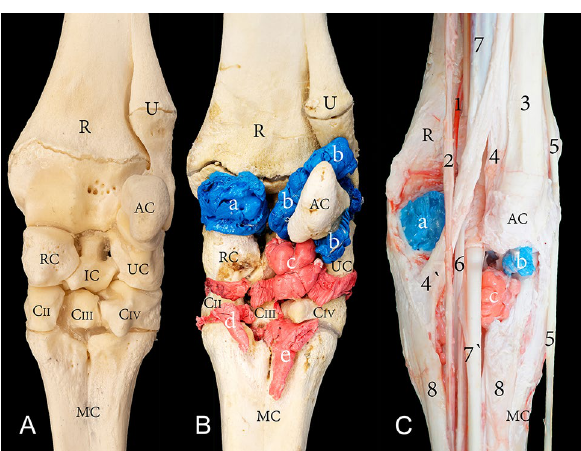
Figure 3. Palmar view of the right carpus showing ( A ) bones, ( B ) casting, and ( C ) dissection. R, the distal end of the radius; U, the distal end of the ulna; AC, accessory carpal bone; RC, radiocarpal bone; IC, intermediate carpal bone; UC, ulna carpal bone; CII, carpal bone II; CIII, carpal bone III; CIV, carpal bone IV; MC, metacarpal bone; a, mediopalmar pouch of the radiocarpal joint; b, lateropalmar pouch of the radiocarpal joint; c, palmar pouch of the intercarpal joint; d, medial pouch of the carpometacarpal joint; e, lateral pouch of the carpometacarpal joint; 1, median artery; 2, median vein; 3, extensor carpi ulnaris tendon; 4, lateral insertion of the flexor carpi ulnaris; 4`, medial insertion of the flexor carpi ulnaris; 5, lateral digital extensor tendon; 6, flexor carpi radialis tendon; 7, humeral head of the flexor digitorum profundis; 7`, flexor digitorum profundis tendon; 8, interosseous medius